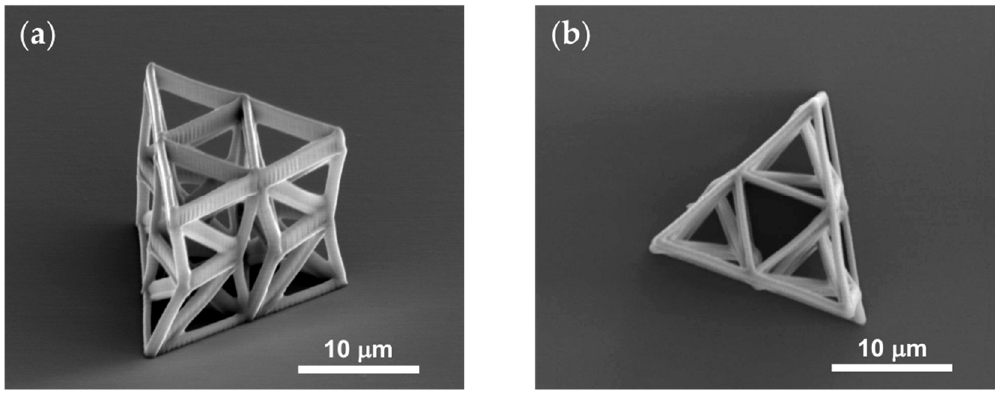
Figure 5. SEM images of a three-unit array. ( a ) axonometric and ( b ) top view.